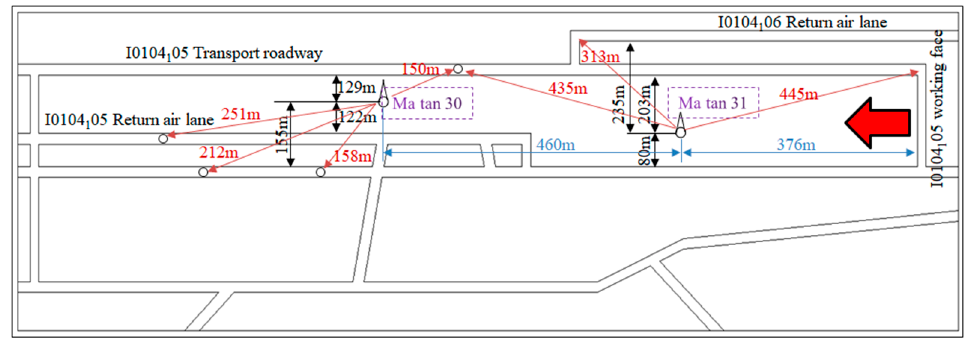
Figure 1. Emission position of H 2 S on driving face .